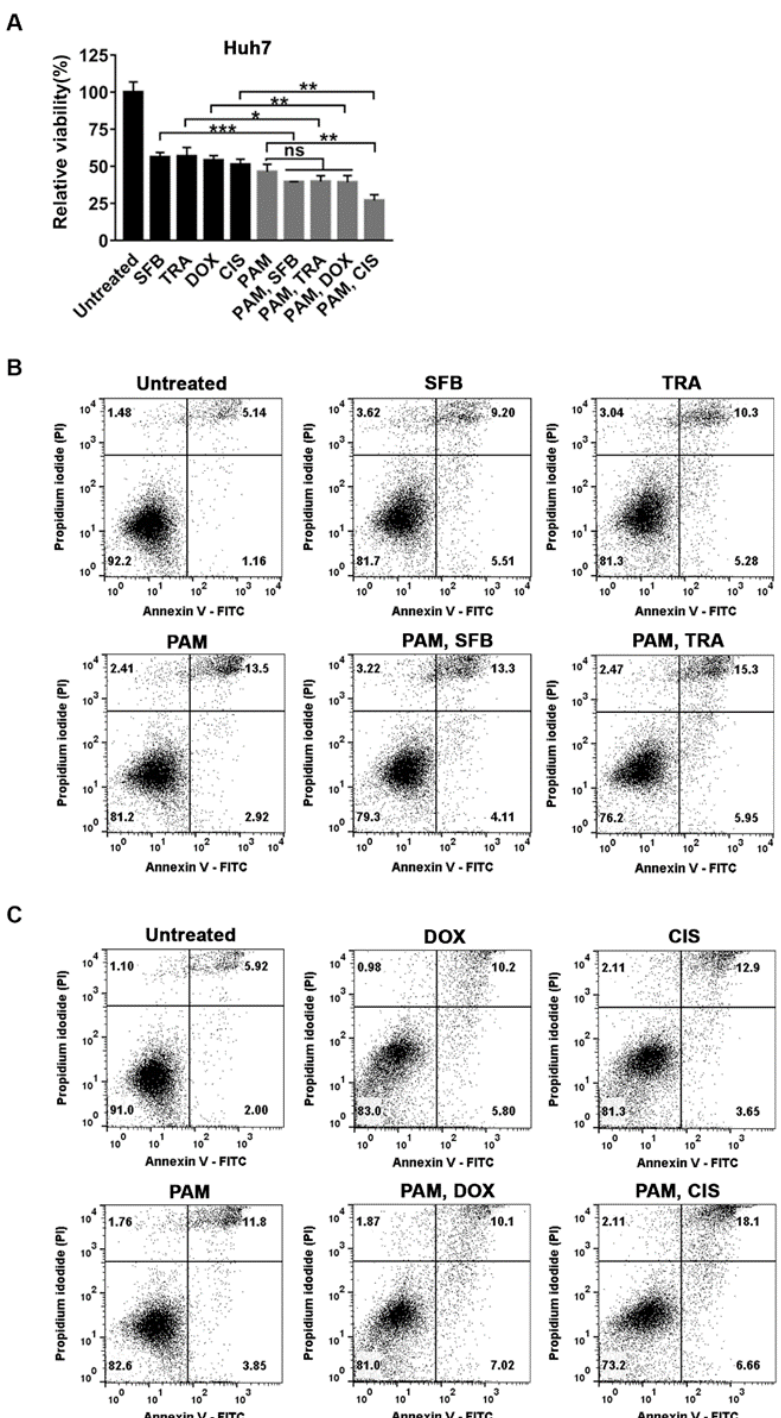
Figure 5. Combinatorial application of PAM and various anti-cancer agents in Huh7 cells. Analysis of the effect of PAM and the IC 50 dose of each anti-cancer agent individually or in combination on the viability of Huh7 cells. ( A ) The viability of cells at 72 h after each treatment was measured using an MTT assay. The relative viability was calculated as the ratio of the viability of the treated to the untreated cells at 72 h. The results are plotted as mean ± SD of at least three independent experiments. * p < 0.05, ** p < 0.01, and *** p < 0.001 indicate significant difference. ns, not significant. ( B , C ) Cell death was examined by flow cytometry after staining the cells with Annexin V-FITC and PI. Untreated cells were used as negative controls.